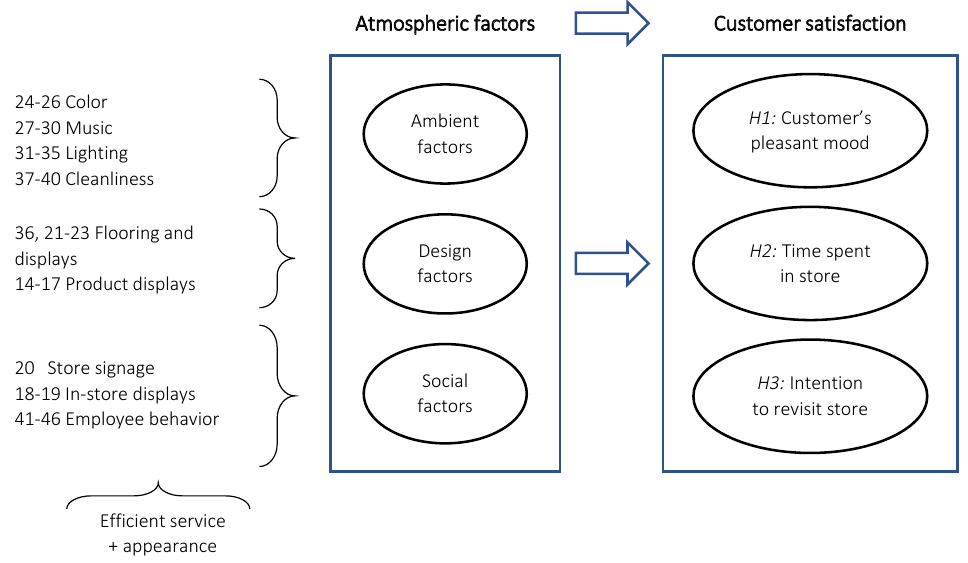
Figure 1. Conceptual